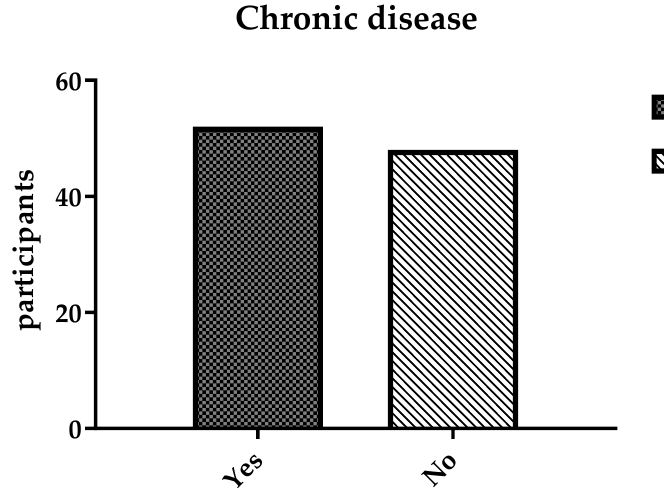
Figure 11. Number of chronic diseases among participants.